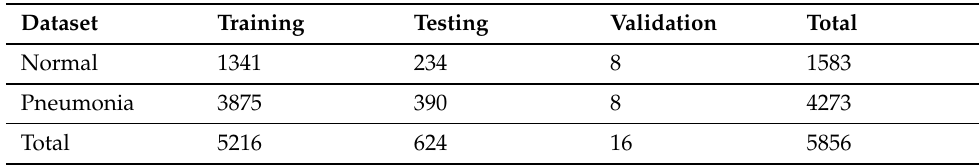
Table 4. Dataset Division for Chest X-ray (Pneumonia).